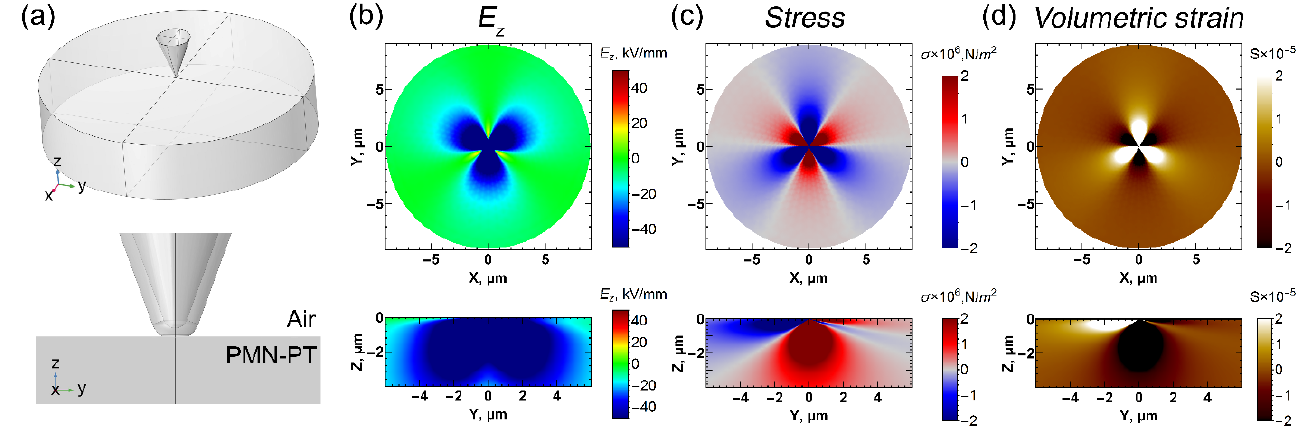
Figure 3. COMSOL modeling for the dry atmosphere: ( a ) scheme, ( b ) logarithm of the electric field polar component, ( c ) stress, ( d ) volumetric strain.